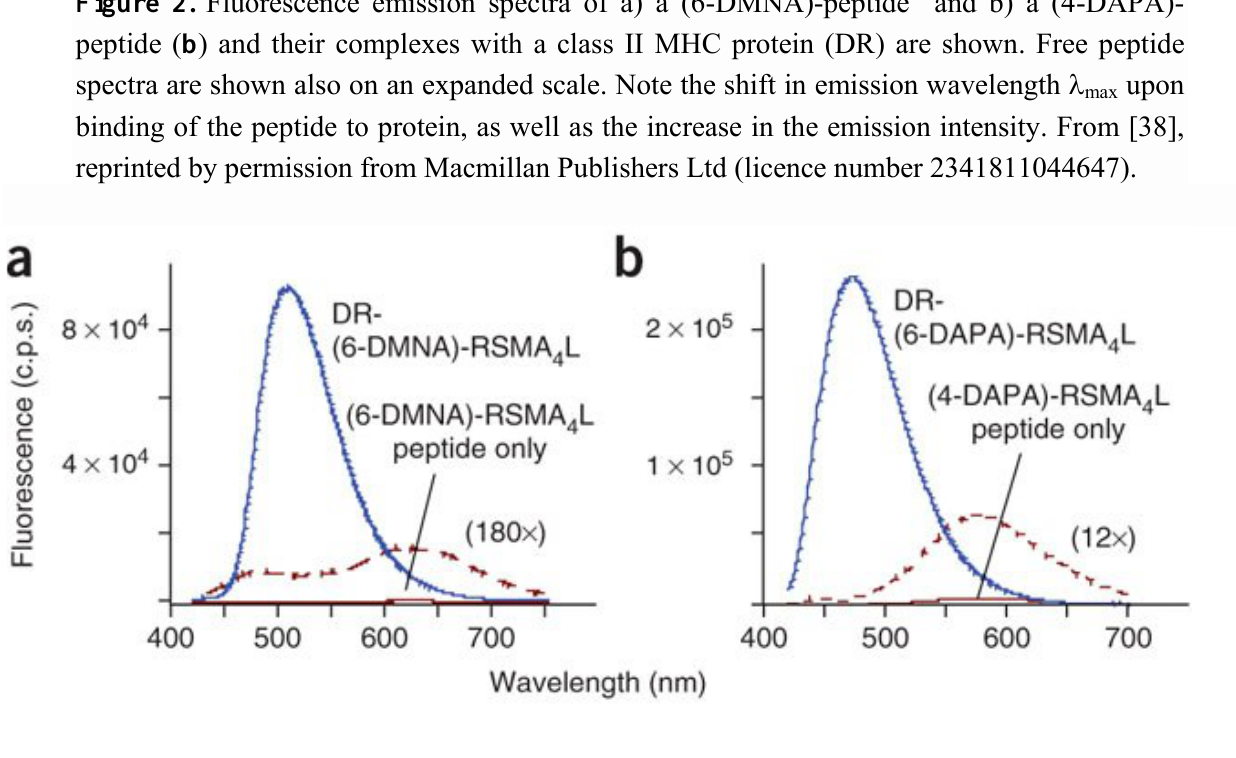
Figure 2. Fluorescence emission spectra of a) a (6-DMNA)-peptide and b) a